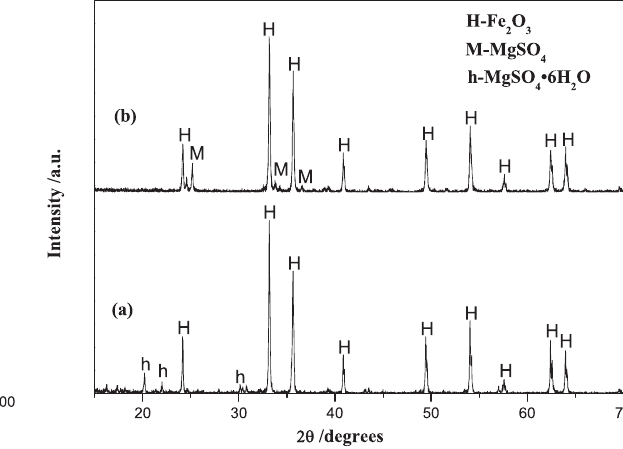
Fig. 3: DSC curve of industrial ferrous sulfate in air.